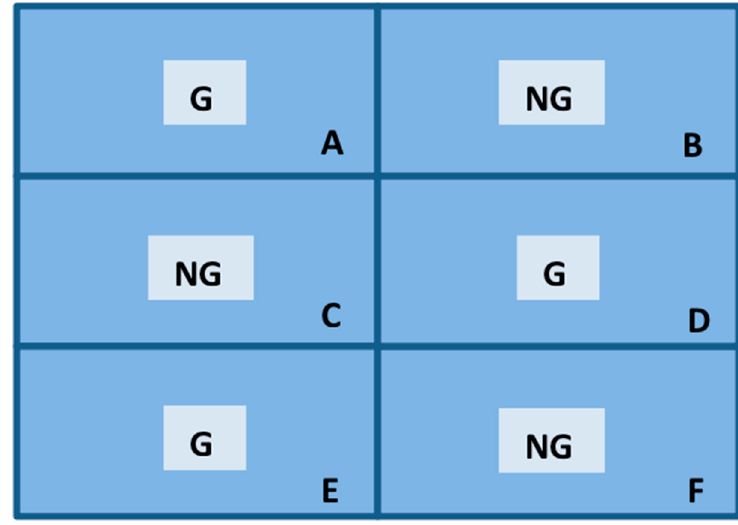
Figure 6. Leaf count test area. ( A – F ): six experimental